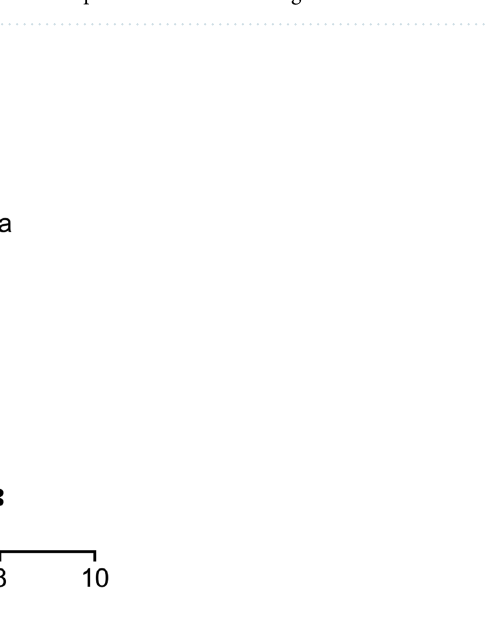
Figure 2. ( A ) Chemical structures of the 4 hits identified from the Biacore screening and ( B ) selection of the preclinical candidate (GLYN122) from the analogue expansion of one of the hit compounds (GLYN026) derived from two adjacent chemical fragments obtained from virtual protein surface scanning.